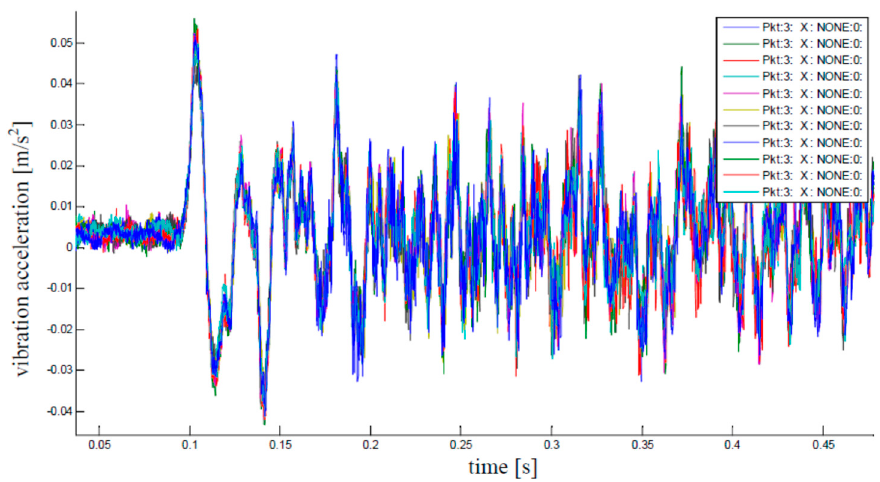
Figure 10. Set of synchronised data collected during all the 11 experiments for one selected measurement point on the structure.